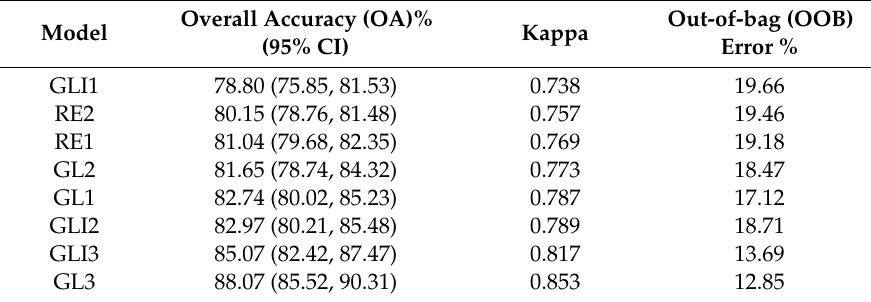
Table 4. The classification accuracies of di ff erent feature models based on the Random Forest (RF) classifier algorithm.